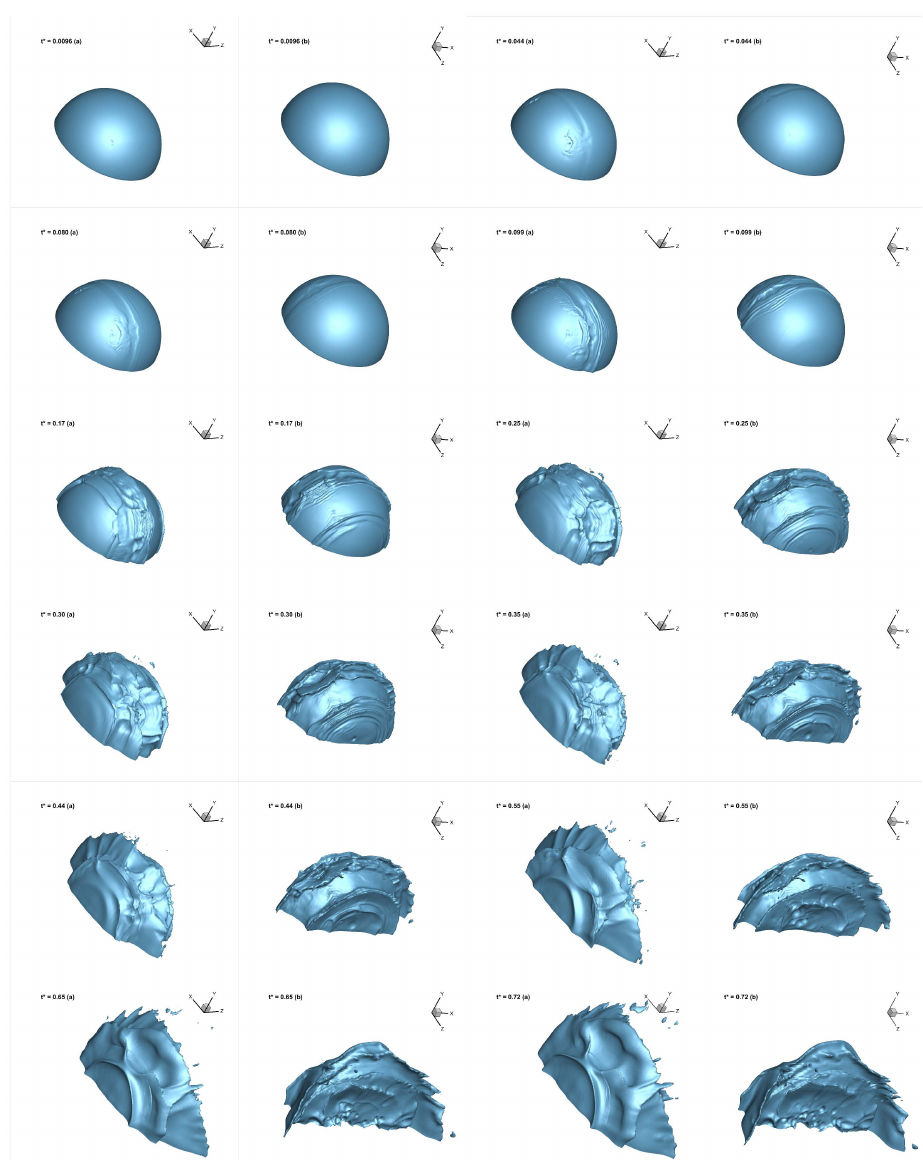
Figure 3. Isosurfaces of liquid volume fraction at α = 0.5, corresponding to twelve different time instants in the interval 0 < t ∗ ≤ 0.72. For each instantaneous picture, both front (a) and back (b) views are